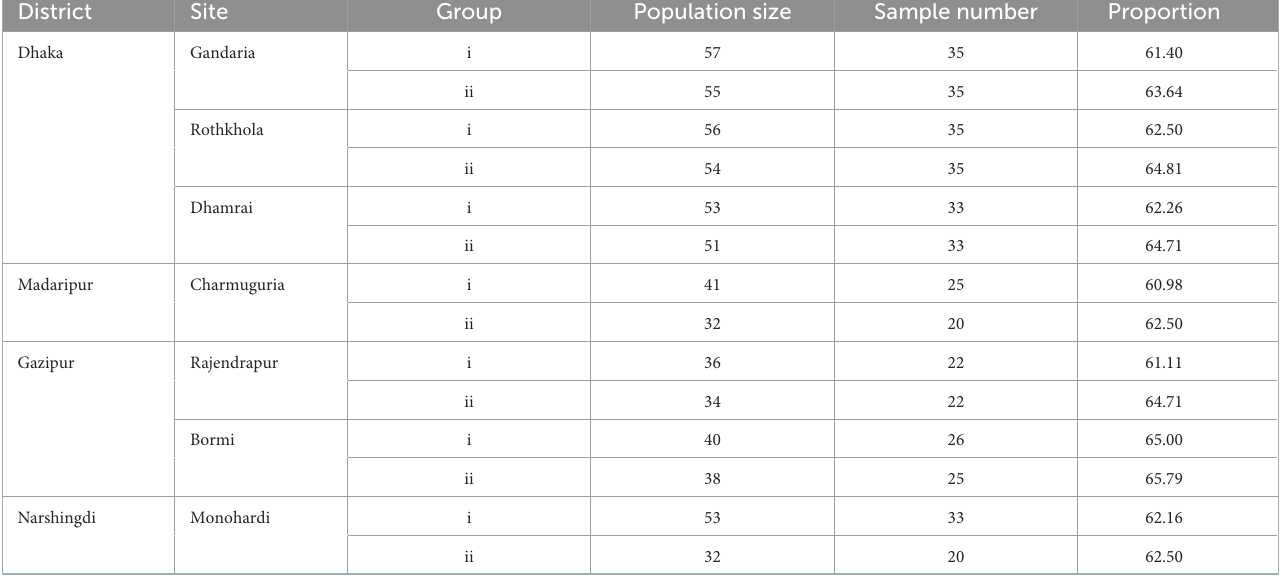
TABLE 1 Frequency distribution of samples from different location. District Site Group Population size Sample number